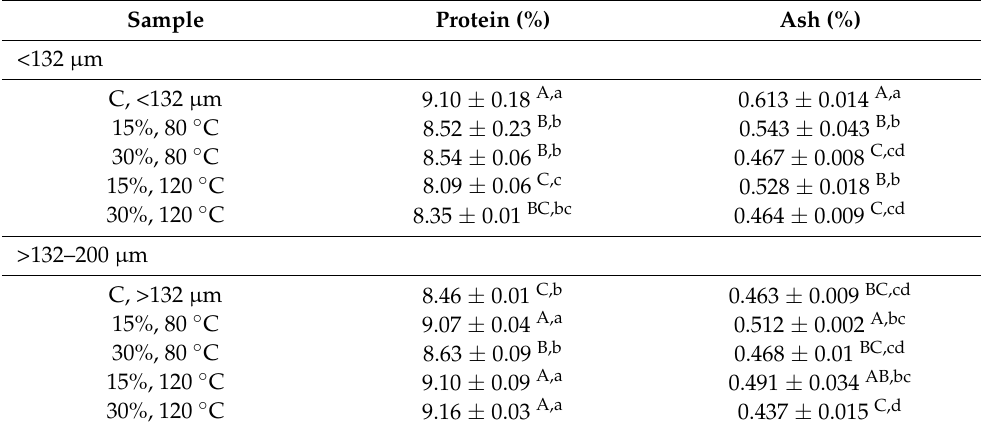
Table 1. Protein and ash content in analyzed gluten-free